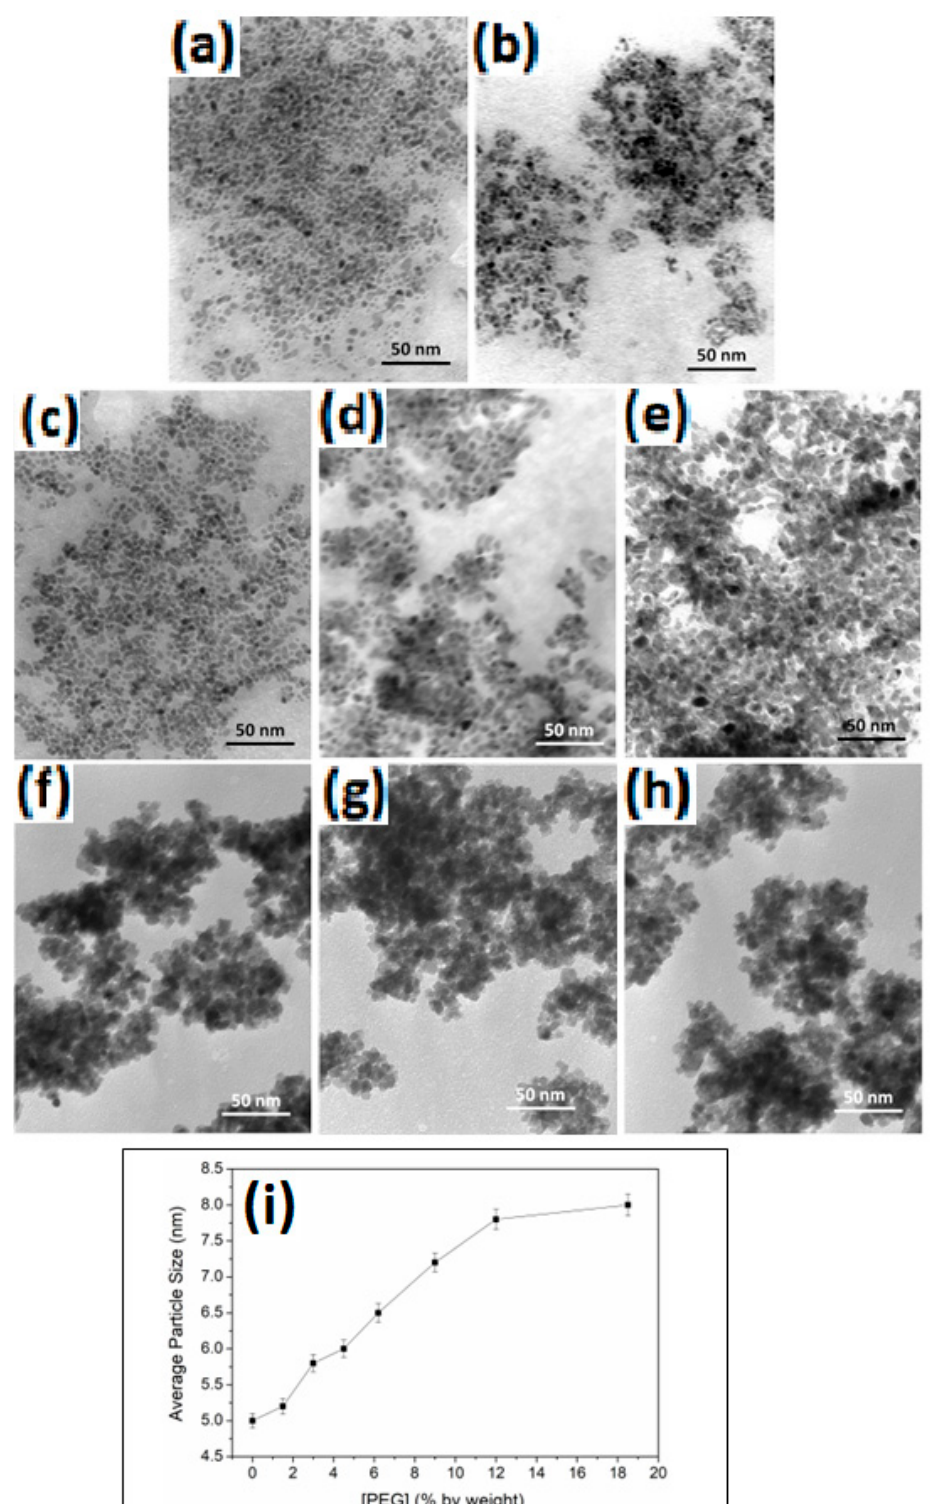
Figure 3. TEM micrographs of PEG-coated MNPs as a function of [PEG]: ( a ) 0%, ( b ) 1.5%, ( c ) 3.0%, ( d ) 4.5%, ( e ) 6.2%, ( f ) 9.0%, ( g ) 12.0%, and ( h ) 18.5% by weight, and ( i ) average particle size distribution as depicted from the TEM micrographs .